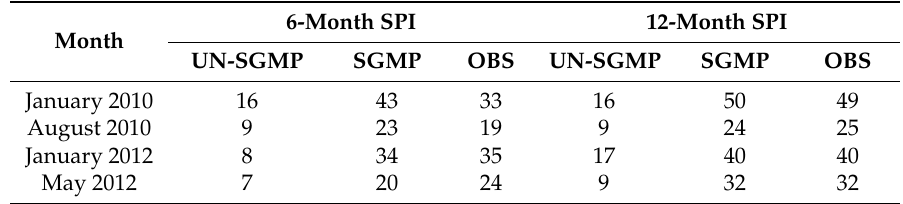
Figure 5. Six-month SPI (SPI6) derived from the OBS data (CN05.1; left panels), the UN-SGMP data (unadjusted 3B42RTV7–CN05.1 merged data; middle panels), and the SGMP data (adjusted 3B42RTV7–CN05.1 merged data; right panels) for January ( a – c ) and August 2010 ( d – f ) and for January ( g – i ) and May 2012 ( j – l ). Table 1. Percentage area in meteorological drought (%) estimated from the UN-SGMP, SGMP, and OBS